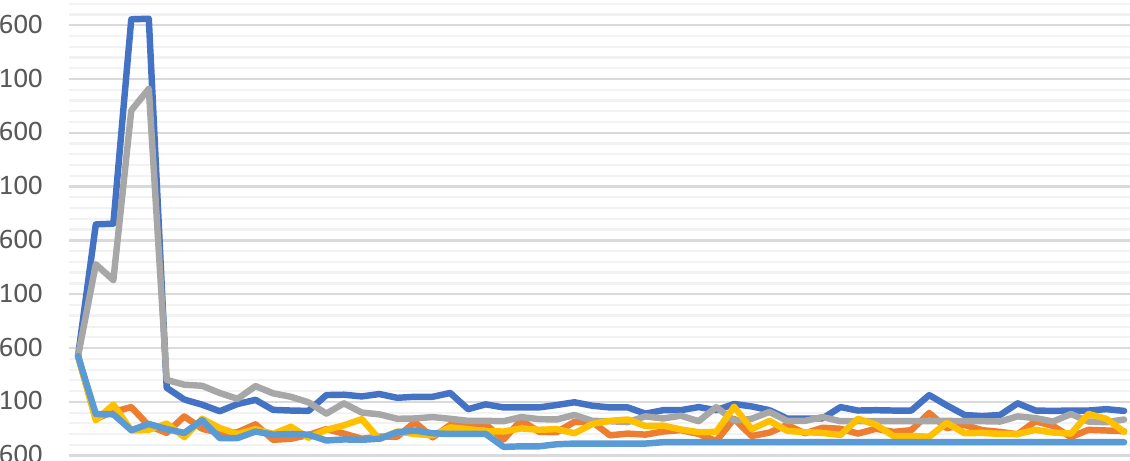
Figure 12. Total route time by bethod using best